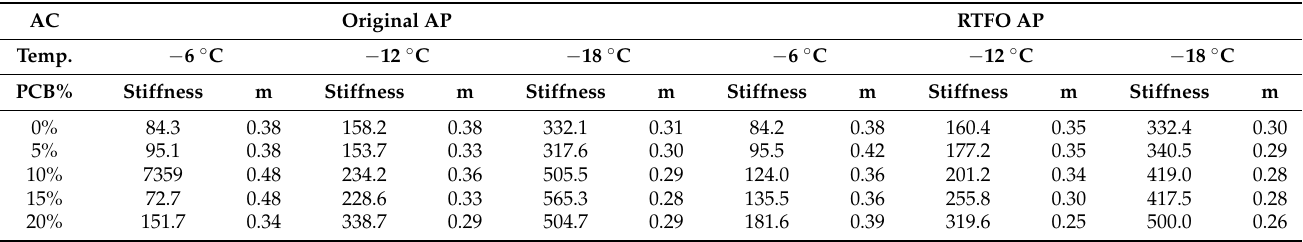
Table 9. BBR test results (creep stiffness and m-value) for AP-3.